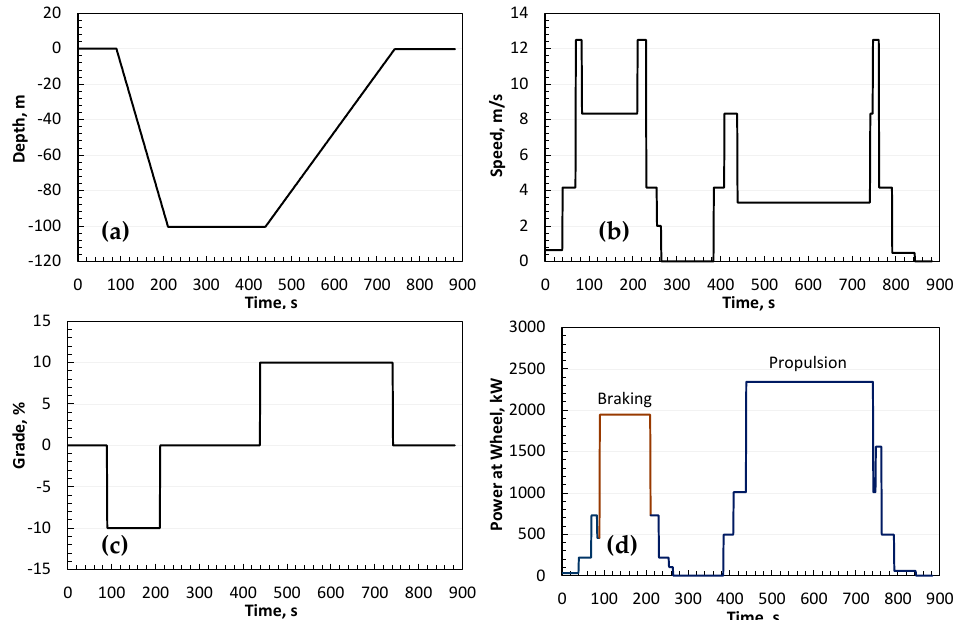
Figure A2. Vehicle duty cycle: depth in the pit mine, grade, speed, and power demand at the wheel. Truck speed and power demand are calculated during the duty cycle, including the segments for truck loaded up the hill, loaded down the hill, empty up the hill, empty down the hill, and on a flat surface. The hybrid fuel cell system has been sized to satisfy the power demand for the speed achieved by the diesel platform: ( a ) Depth; ( b ) Speed; ( c ) Grade and ( d ) Power at wheel